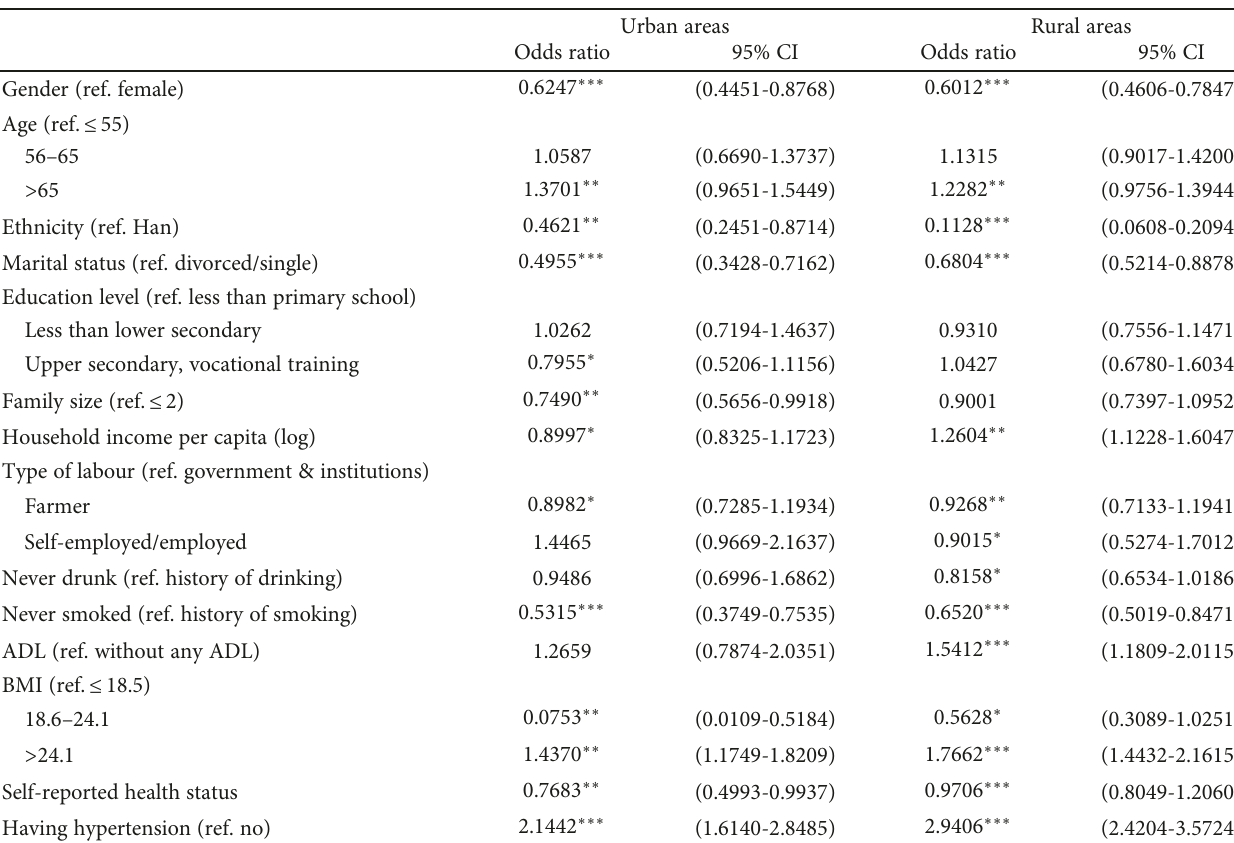
Table 4: Logistic regression model on prevalence of self-reported diabetes among middle-aged and elderly